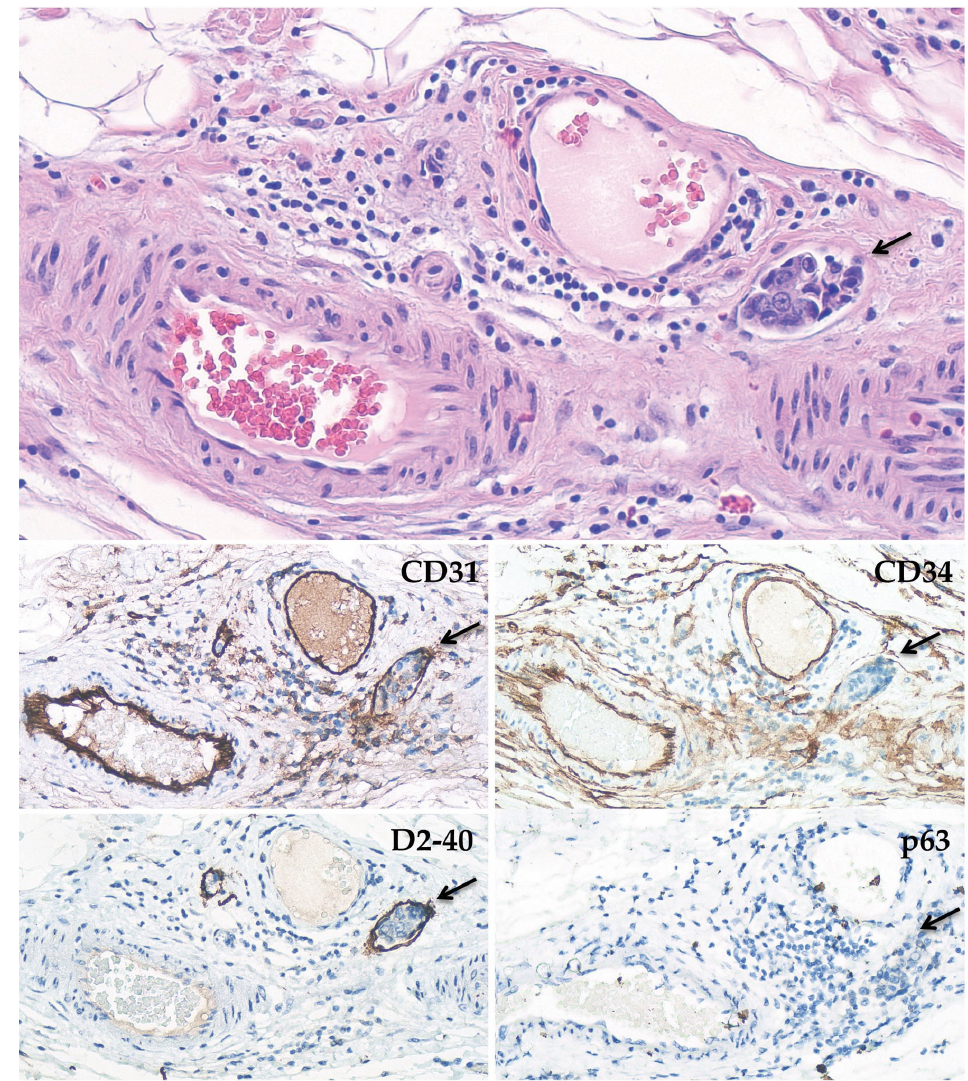
Figure 1. Representative pictures of an LVI tumor embolus (arrow) walled by an endothelial cell layer positive for CD31, CD34, and D2-40 immunostaining. p63 shows the absence of myoepithelial cells (200× magnification).